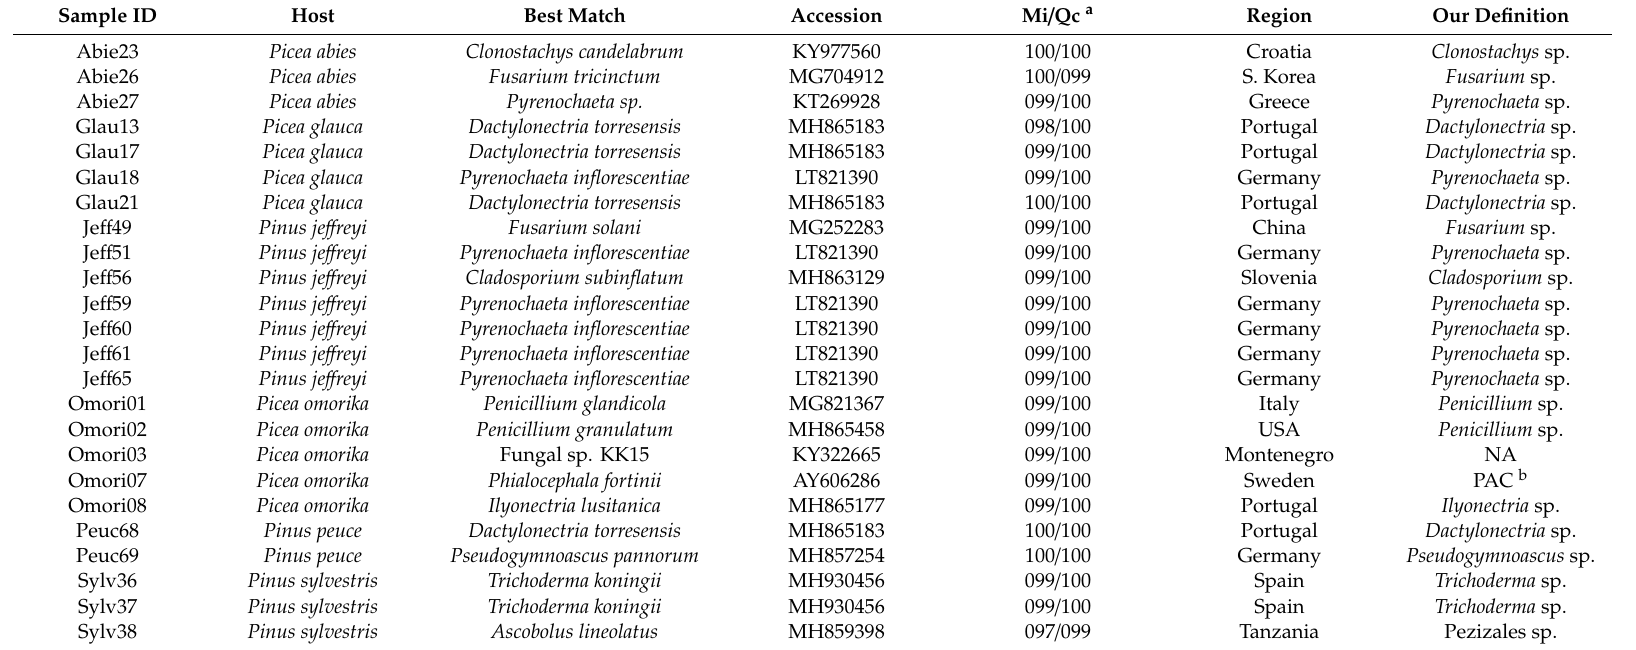
Table 3. Sequenced root endophytes and their best matches in the National Center for Biotechnology Information (NCBI) database based on concatenated internal transcribed spacer (ITS1-ITS2) sequences. The samples are grouped according to host tree species, and the GenBank accession numbers, sequence similarity (maximum identity / query coverage), as well as region of the homologous sequences used to establish molecular identity are